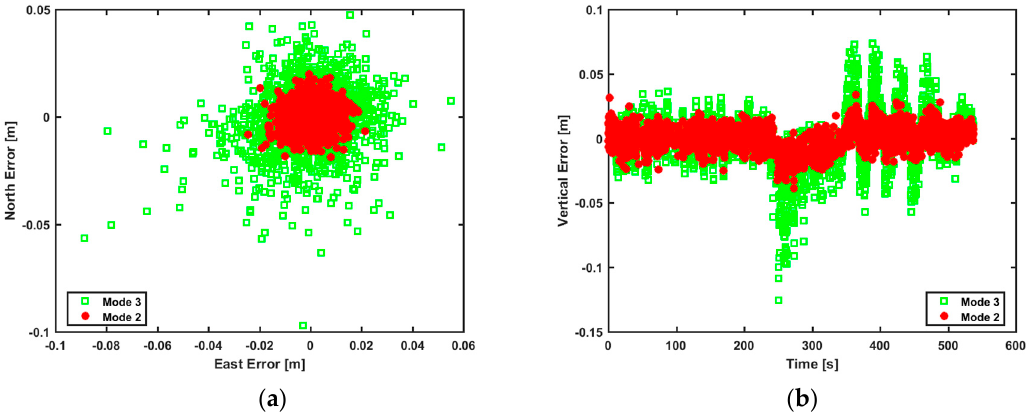
Figure 18. Error scatterplots for modes 2 and 3 in test 1. ( a ) Horizontal direction; ( b ) vertical direction.